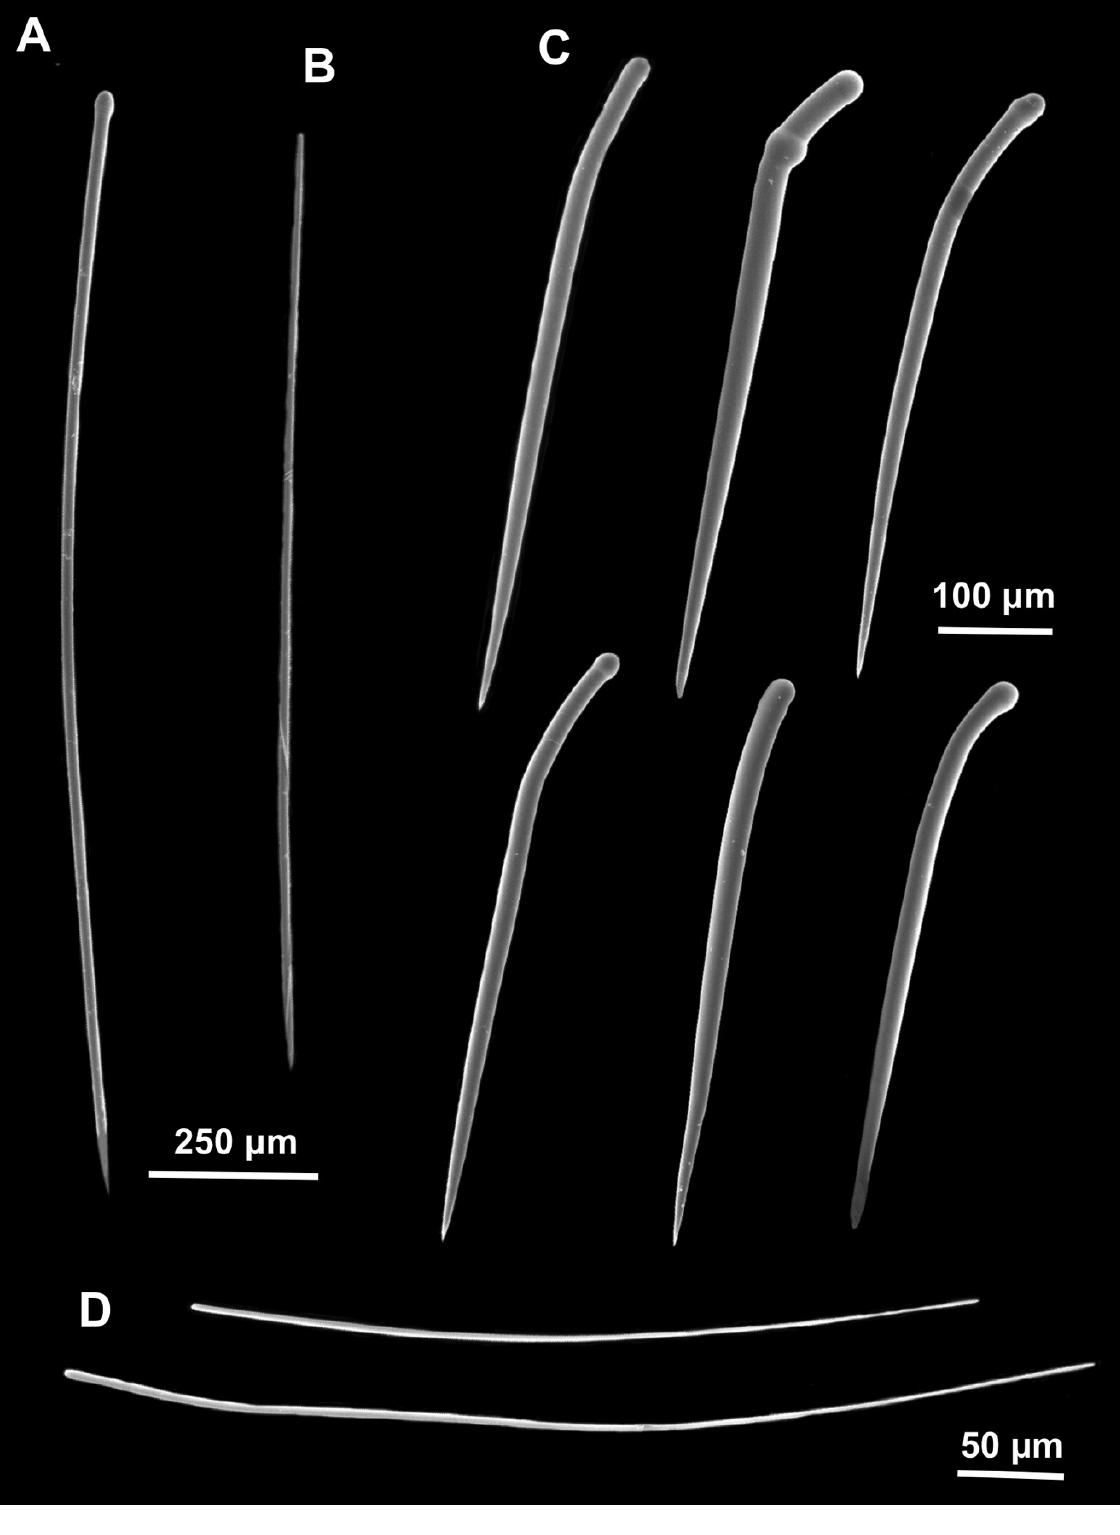
Fig. 6. Spicules of Axinella coronata Bertolino, Costa & Pansini sp. nov., holotype (CILE 22; MSGN 61494). A . Tylostyles. B . Styles. C . Styles bend near the head similar to rhabdostyles. D . Thin and sinuous